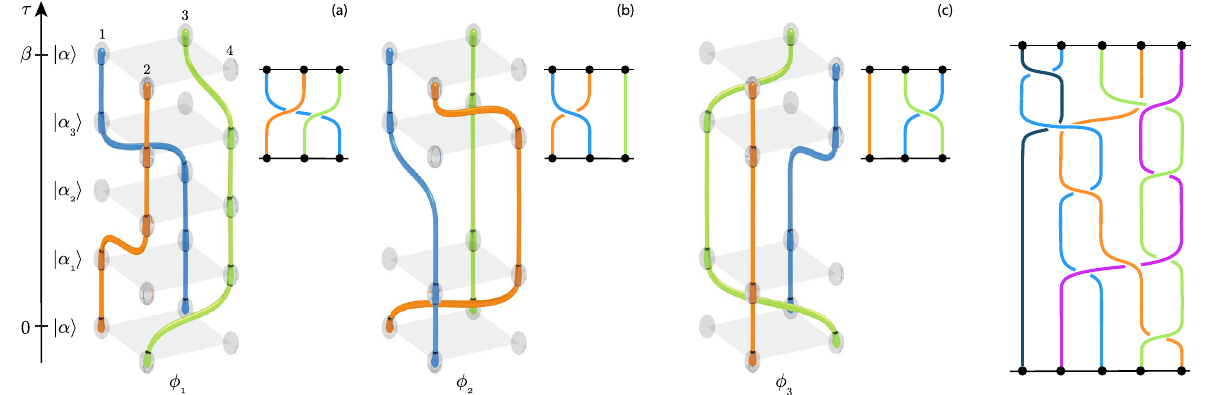
Figure 1. Panels ( a ), ( b ) and ( c ): three examples of configurations of 3 particles on a 2 × 2 lattice. Configurations are collections of particle-paths in space and imaginary-time τ and are specified by a sequence of Fock states | α i � ordered in τ . Smaller figures are a 2D depiction of the geometric braid only including occupied sites and in which cut worldlines are the ones behind another worldline. Particles are indistinguishable, colors are only meant to guide the eye. Panel ( d ): example of a more complex geometric braid involving 5